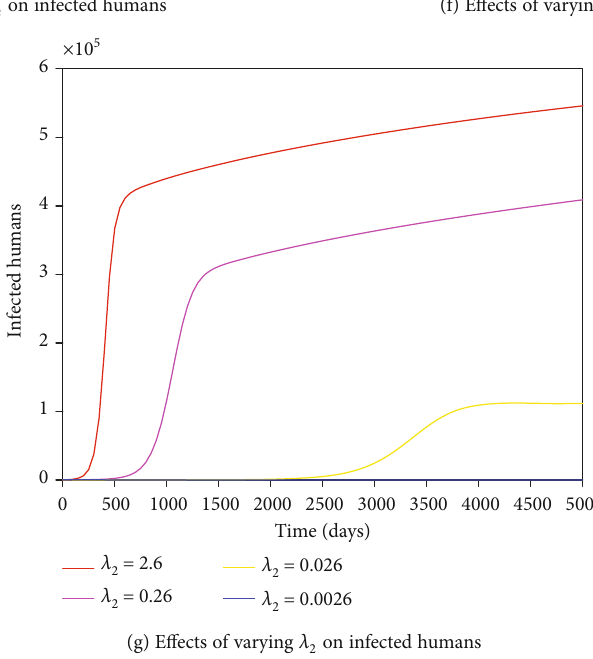
Figure 6: E ff ects of varying sensitive parameters on infected